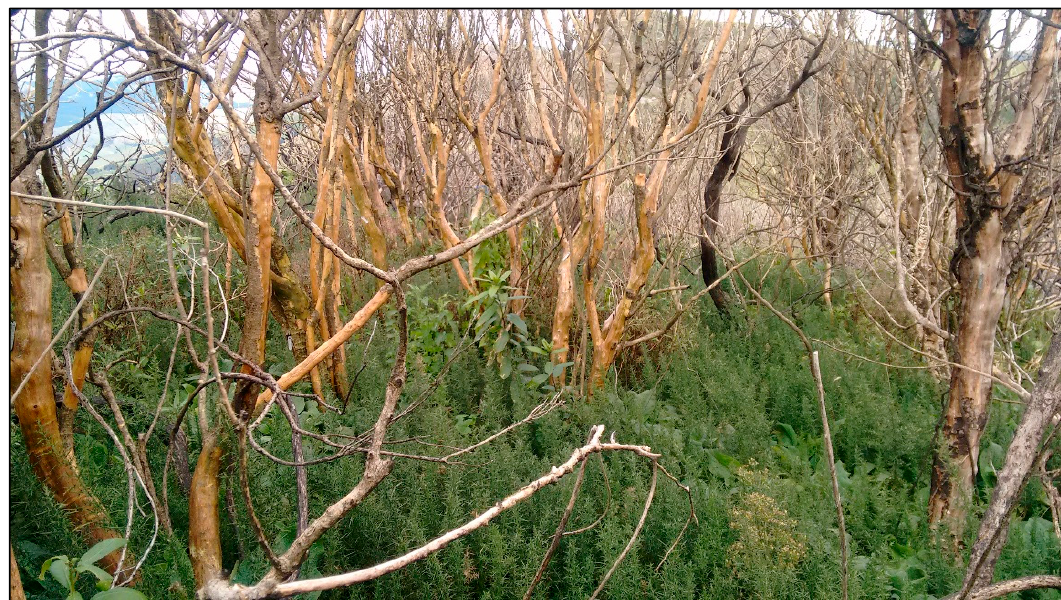
Figure B6. High density of Ulex europaeus seedlings regenerating under the burnt bush canopy. In the center of the picture, a basal resprout of Melicytus ramiflorus overcame the thick layer of U. europaeus seedlings. The photography was taken in plot 3, 18 months after the fire.